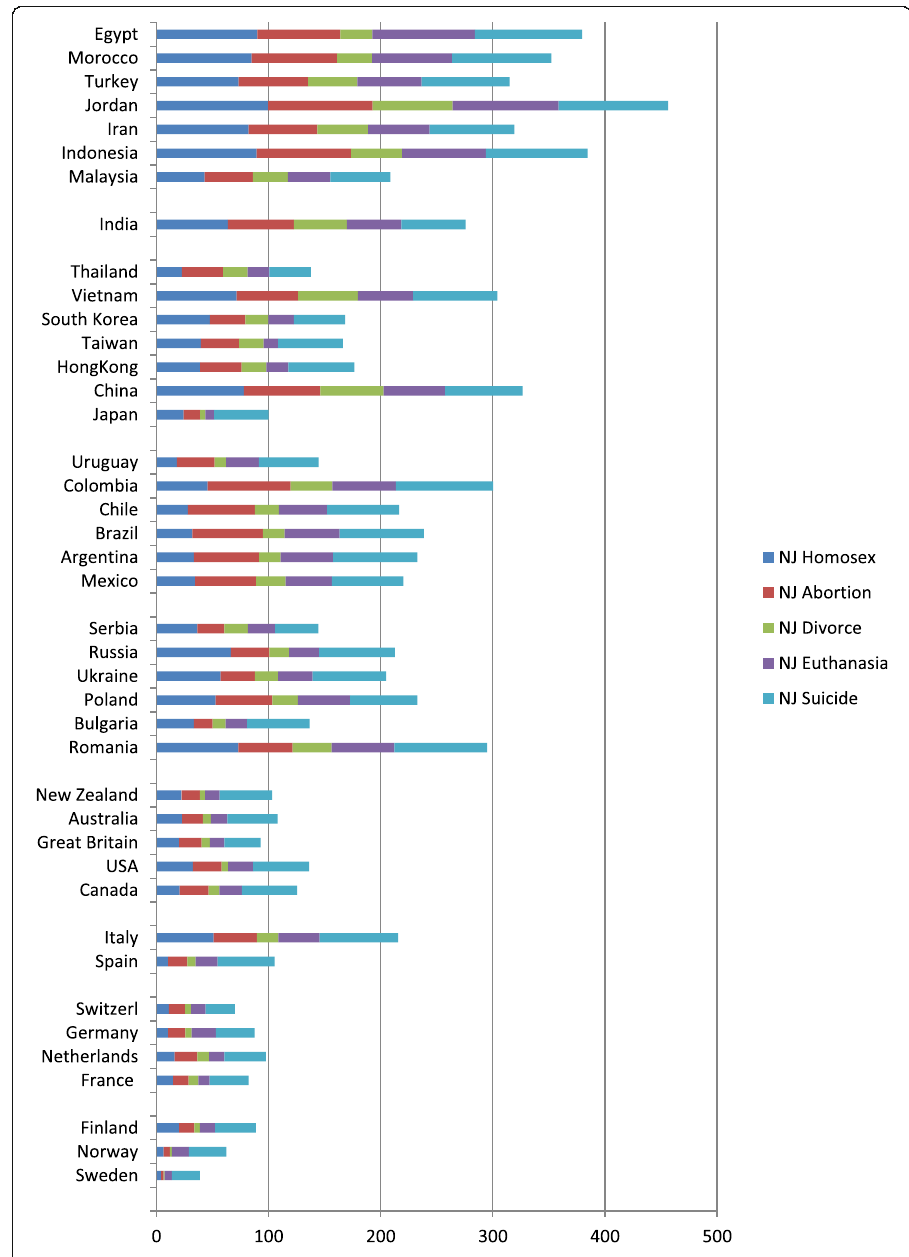
Fig. 9 Degree of ethical conservatism: sum of percentages never justifying (NJ) homosexuality, abortion, divorce, euthanasia and suicide. Population 18+, latest European and World Values Studies, 2000 –